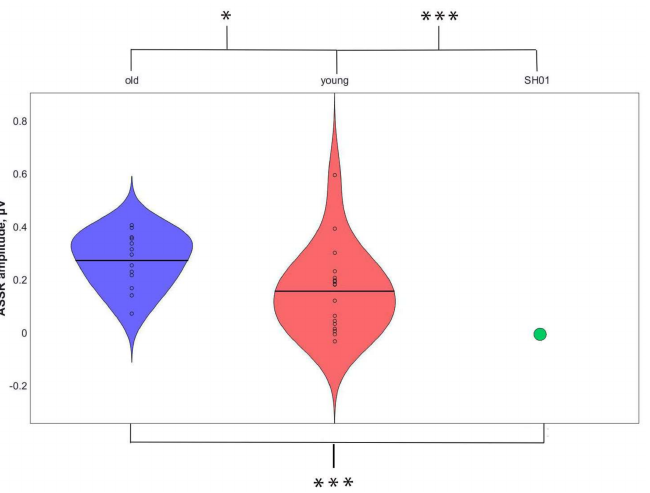
Figure 5. Individual values of 40-Hz ASSR across the groups (Fz electrode). The old TD group’s values are shown in the first column, the young TD group’s values are shown in the second, and SH01’s values are shown in the third. (* shows significant differences p < 0.05, *** shows significant differences p <